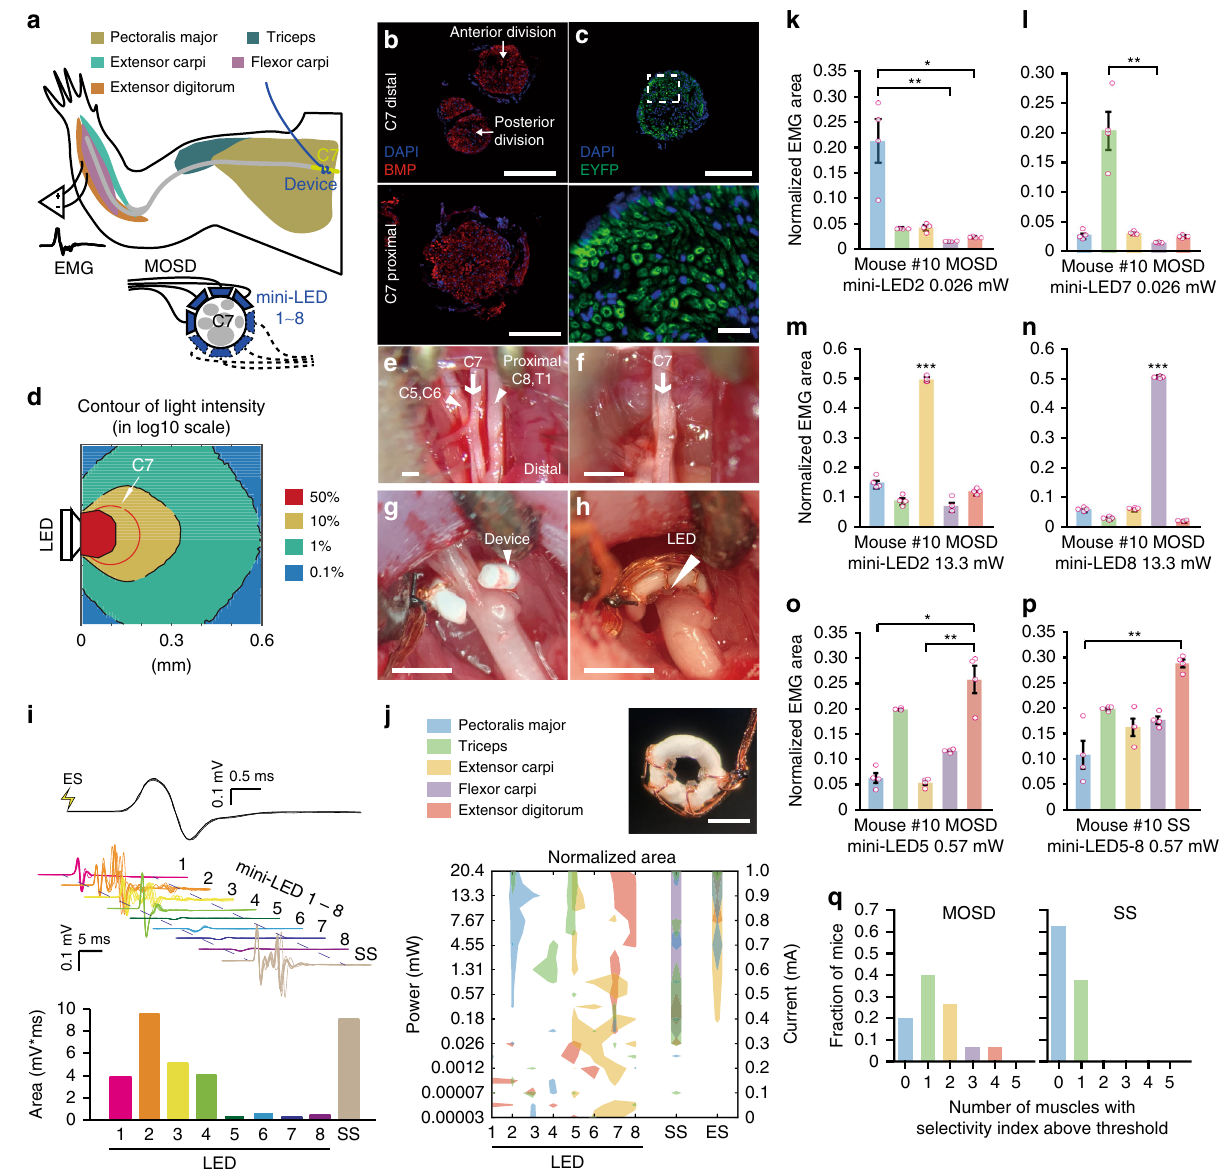
Fig. 5 MOSD stimulation of C7 nerve bundle in Thy1 - ChR2 - EYFP mice. a Schematic of experimental set-up. MOSDs were implanted on the proximal side of C7 nerve bundle and electromyography was recorded. b Immuno fl uorescence staining of C7 nerve at distal side (upper) and proximal side (lower). Red, BMP. Blue, DAPI. c Expression of EYFP in C7 nerve of Thy1 - ChR2 - EYFP mice. Green, EYFP. Blue, DAPI. d Monte-Carlo simulation of mini-LED light intensity across and around C7 nerve. e – h Illustration of MOSD implantation process on C7 nerve. e Identi fi cation of C5 – 8 and T1 nerves. f excise C5 – 6, 8, and T1 nerves. g MOSD implanted on the proximal side of C7 nerve. h MOSD was turned 180°. i Representative electromyogram from Triceps by different mini- LEDs (20.4 mW, 20 msec-on/2 sec-off, calculated light intensity at the mini-LED: 888 mW mm − 2 ; in the middle: 602 mW mm − 2 ; at the far end: 267 mW mm − 2 ) of MOSD, single-site optogenetic (SS) (81.6 mW, 20 msec-on/2sec-off), and electrical stimulation (ES) (0.6 mA, 0.2 msec-on/1 sec-off) in one mouse. Myoelectric area was presented below. j MOSD (top right) with mini-LED (bottom) representative response pattern of Pectoralis major (PM), Triceps (Tr), Extensor carpi (EC), Flexor carpi (FC), and Extensor digitorum (ED) by different mini-LEDs of MOSD, SS and ES in one mouse. Left Y axis: mini-LED light power. Right Y axis: current used for ES. k – o Representive mouse showed selectivity for PM, Tr, EC, FC, and ED by MOSD ( n = 4 trials. k , l , o - Friedman ’ s ANOVA on Ranks with Tukey post hoc; m , n : One way ANOVA with Tukey post hoc, * P < 0.05, ** P < 0.01, *** P < 0.001). p The same mouse showed selectivity in only one muscle by SS. ** P < 0.01, n = 4 trials, Friedman ’ s ANOVA on Ranks with Tukey post hoc. q Summarized distribution of the fraction of mice with numbers of muscles which showed selectivity ( n = 15 mice for MOSD, n = 8 mice for SS). Data are presented as mean ± s.e.m. Scale bars are 100 µ m ( b , c (top)), 10 µ m ( c (bottom)) and 400 µ m ( e – h , j (top right)) labeled with one color, suggesting that one muscle was selectively myoelectric areas of ED, PM, Tr, EC, and FC muscles were all activated. The LED/light intensity corresponding to single- above 95% threshold (Fig. 5j). Likewise, ED, PM, Tr and EC colored territory would thus be chosen as selective stimulation muscles were activated when C7 was electrically stimulated conditions. When LEDs 1 – 4 were turned on, namely single-site (Fig. 5j). Moreover, in both single-site optogenetic stimulation optogenetic stimulation, EMG recording showed that the and electrical stimulation, the relative ratio of activation levels in NATURE COMMUNICATIONS| (2019) 10:2790